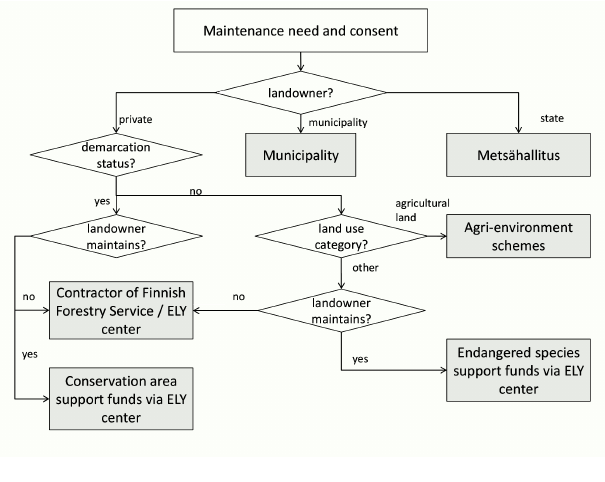
Fig. 2 . Sources for habitat maintenance funding for a false heath fritillary habitat depending on the type of landowner, demarcation status and farmer status of the habitat, and the landowner’s ability to carry out habitat maintenance independently. ELY center, Centre of the Economic Development, Transport and the